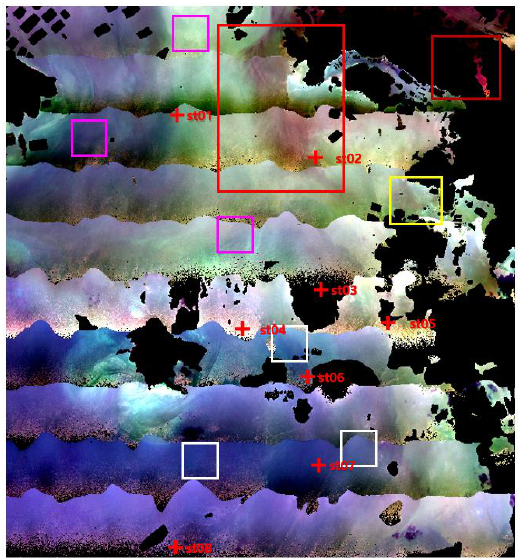
Figure 10 . Comparison of the R rs spectra of L a correction (blue line), L a and L r correction Figure 9 . Natural color RGB composite for the mosaic image (red line), and in-situ measurements (greed line) of atmospheric-corrected hyperspectral images for sampling stations (a) st01, (b) st02, (c) st04, (d) st06, (red crosses: in-situ sampling sites for atmospheric correction (e) st07, and (f) st08. verification). L a -corrected (blue line, Figure 10) and L a + L r -corrected (red line, Figure 10) results. The L a -corrected R rs spectrum showed values